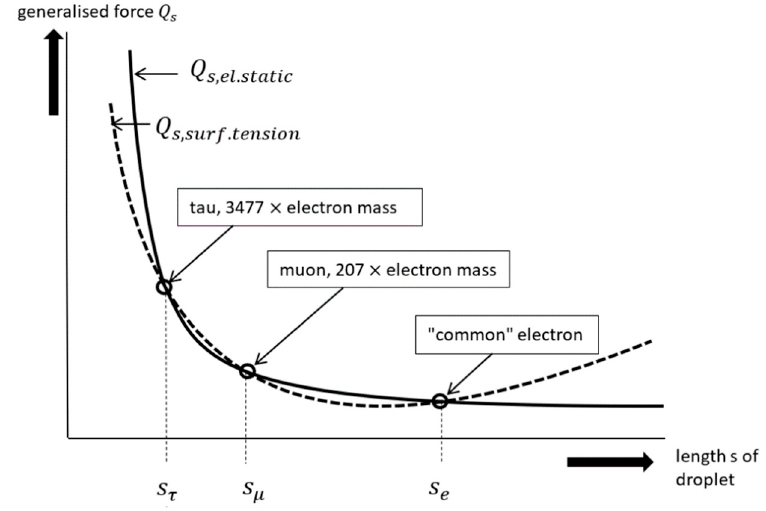
Figure 3. The three equilibria of the droplet, and their tentative identification with the three charged leptons.